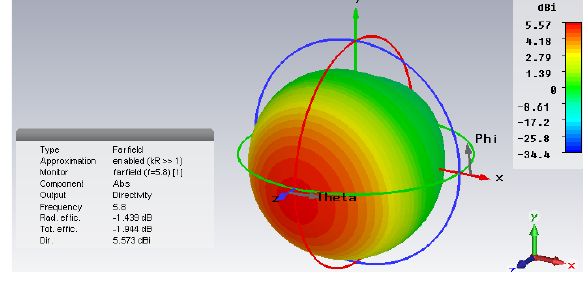
Figure 19. Far field region for Dupont-951.